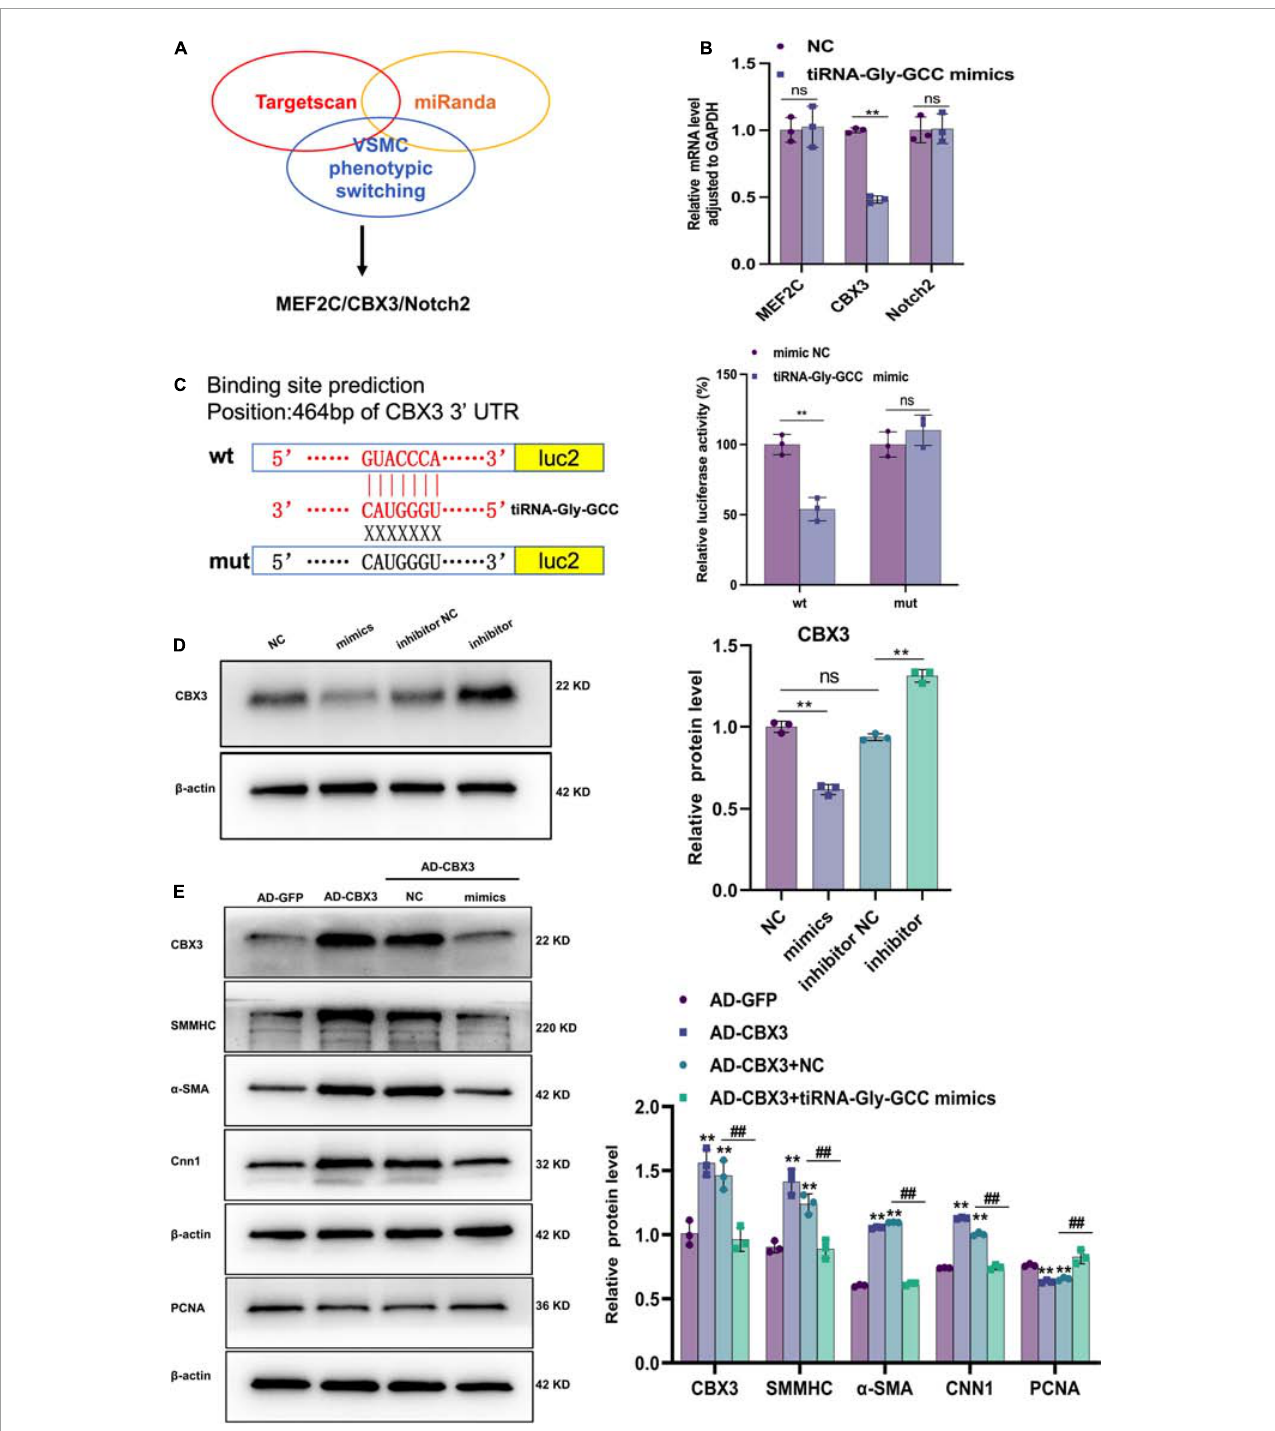
FIGURE6 CBX3 is the target of tiRNA-Gly-GCC. (A) Targets of tiRNA-Gly-GCC were predicted by TargetScan and miRanda database. Then the targets involved in VSMCs phenotypic switching were selected. (B) The mRNA levels of potential target genes (MEF2C, CBX3, and Notch2) were analyzed using qRT-PCR after HASMCs were transfected with NC or mimics for 24 h and normalized to GAPDH. Data are presented as the mean ± SD. n = 3, **p < 0.01, ns: not significant (versus NC). (C) The right panel represents a schematic representation of dual-luciferase reporter gene assay about tiRNA-Gly-GCC binding sites within CBX3 3 (cid:48) UTR. Wild-type group (wt), mutant group (mut). Luc2, firefly luciferase reporter gene. The right panel refers to quantitative results of fluorescence intensity, from three independent experiments. Data are presented as the mean ± SD. n = 3, **p < 0.01, ns: not significant (versus mimic NC). (D) The left panel refers to representative image of Western blot analysis for the expression of CBX3 on HASMCs transfected with negative control (NC), tiRNA-Gly-GCC mimic, inhibitor NC or tiRNA-Gly-GCC inhibitor. The right panel refers to densitometric quantification of CBX3 expression normalized by β -actin, from three independent experiments. Data are presented as the mean ± SD. n = 3, **p < 0.01, ns: not significant, compared with the two groups, which are labeled by a horizontal line. (E) The left panel refers to representative image of Western blot analysis for the expression of CBX3, SMMHC, α -SMA, CNN1, and PCNA. The right panel refers to densitometric quantification of these proteins expression normalized by β -actin, from three independent experiments. HASMCs were infected with AD-GFP (control) or AD-CBX3 vector for 24 h and then transfected with NC or tiRNA-Gly-GCC mimics for another 24 h. Data are presented as the mean ± SD. n = 3, **p < 0.01 (versus AD-GFP). ## p < 0.01 compared with the two groups, which are labeled by a horizontal